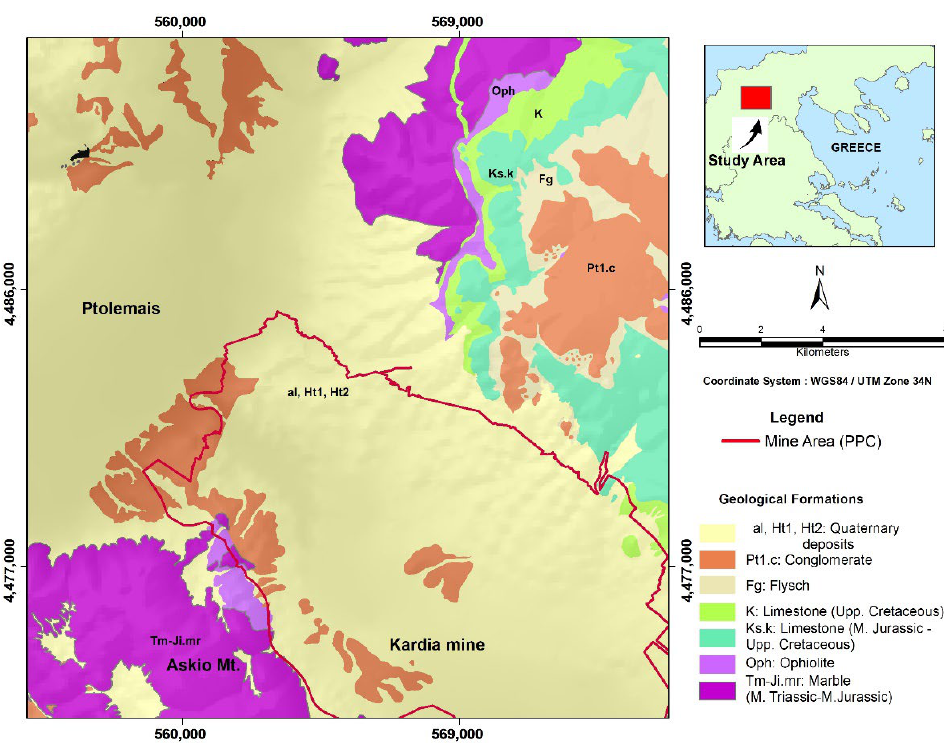
Figure 2. Simplified geological map of the Ptolemais area, located NW and SE of the city of Ptolemais (based and modified on Institute of Geology and Mineral Exploration (IGME) geological sheet, Ptolemais 1:50.000, [21]).